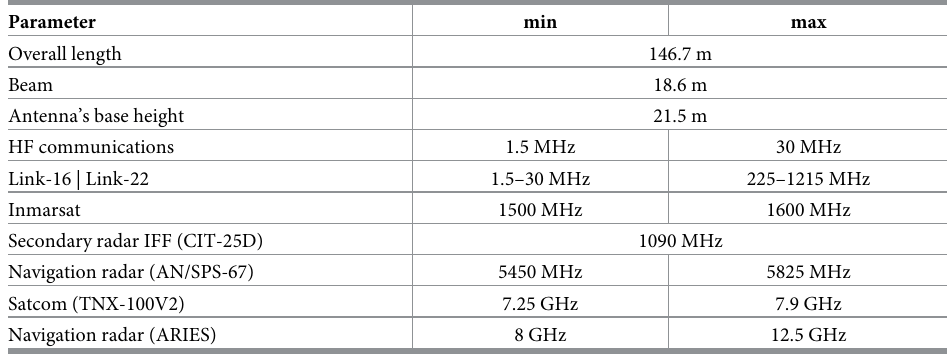
Table 1. F100 class main dimensions and equipment. Parameter